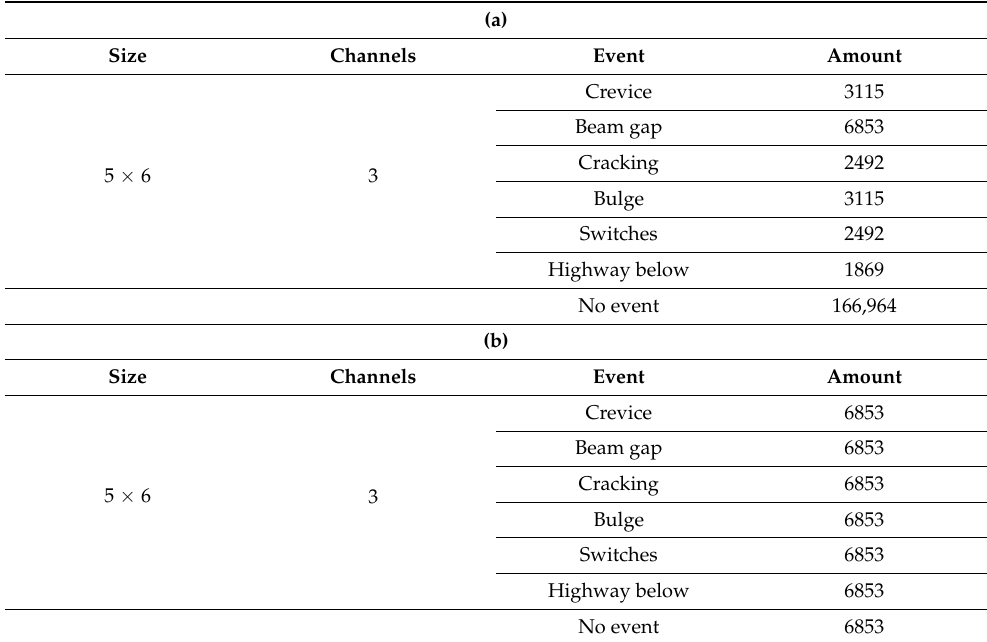
Table 2. ( a ). Overall dataset obtained by data segmentation. ( b ). Balanced dataset obtained by oversampling from the original overall dataset.